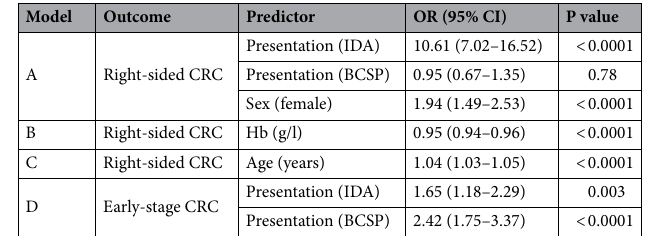
Table 2. Summary of logistic regression analyses showing variables predictive of right-sided CRC (models A–C) and early-stage CRC (model